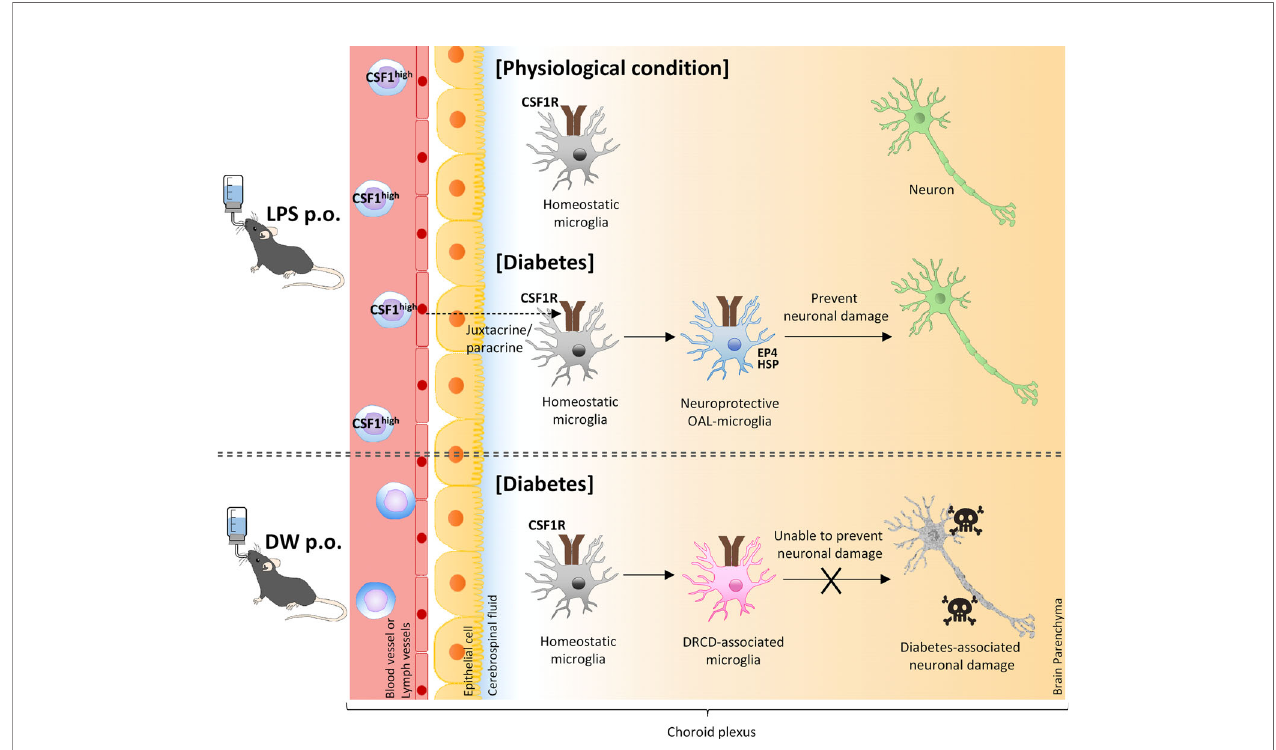
FIGURE 6 | A model of transformation into neural microglia through OAL. OAL induces m-CSF1 expressing leukocytes, which patrol and maintain CNS homeostasis under physiological conditions. Under diabetes-induced pathological conditions, microglia transform to a neuroprotective phenotype mediated by m-CSF1 in a juxtacrine/paracrine manner, and prevent neuronal